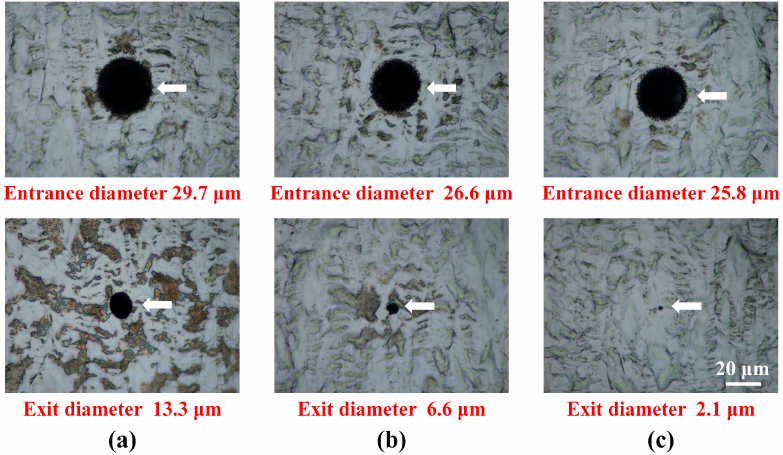
Figure 4. Typical images of a demonstration of vibration-assisted femtosecond laser hole drilling with taper angle control using vibration amplitudes of ( a ) 13 μ m; ( b ) 6.5 μ m; and ( c ) 1.3 μ m.